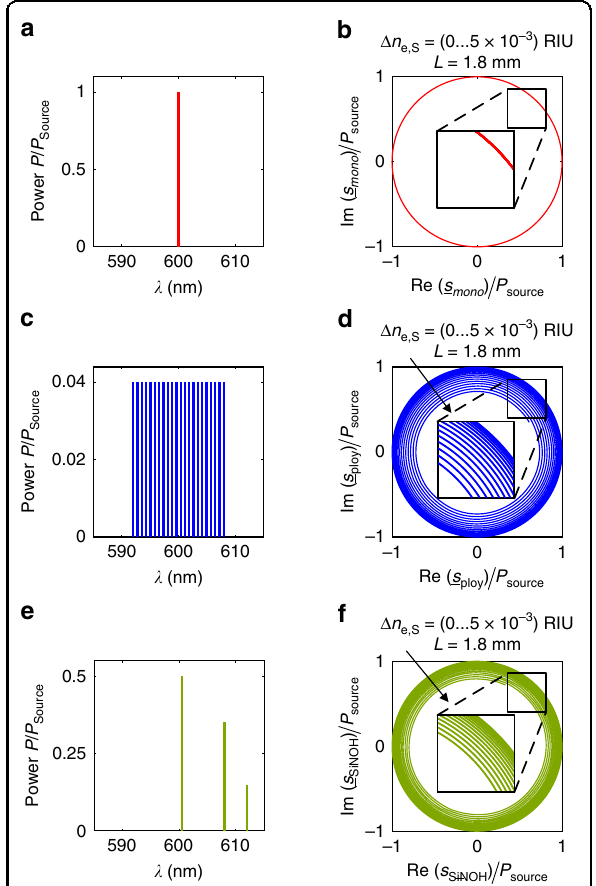
Fig. 4 Calculated complex Clarke fi elds s of an MZI with 3 × 3 MMI combiner at the output for different light sources. a , c , e Normalized emission spectrum for a monochromatic laser line, Sub fi gure 4a, for a polychromatic laser with equally spaced lines of equal powers, Sub fi gure 4c, and for a SiNOH laser with three monochromatic lasing lines located at different wavelengths and exhibiting different powers, Sub fi gure 4e. b , d , f Clarke fi elds s calculated from the three output powers of the 3 × 3 MMI according to Eq. 3 and plotted in the complex s -plane. The geometrical lengths of the sensing and reference arms amount to L = 1.8mm, and the effective refractive-index difference Δ n e,S varies between 0 and 5×10 – 3 RIU. We assume a wavelength of 600 nm. b For the monochromatic laser, Sub fi gure 4a, s mono describes a circle with radius j s mono j ¼ P Source , centred at the origin. d For the polychromatic laser, Sub fi gure 4c, the magnitude j s poly j decreases with increasing Δ n e,S, and s poly describes a spiral. f For the SiNOH laser described in Fig. 3, the magnitude j s SiNOH j decreases with increasing Δ n e,S, , as shown in Sub fi gure 4f, but the decrease is smaller than for the case of j s poly j . In real experiments, non-ideal MMIs and GCs could lead to an elliptical deformation of the otherwise circular or spiral-shaped locus of the corresponding Clarke fi eld s in the complex plane. This can be compensated by transforming the ellipse back into a circle with a unity radius